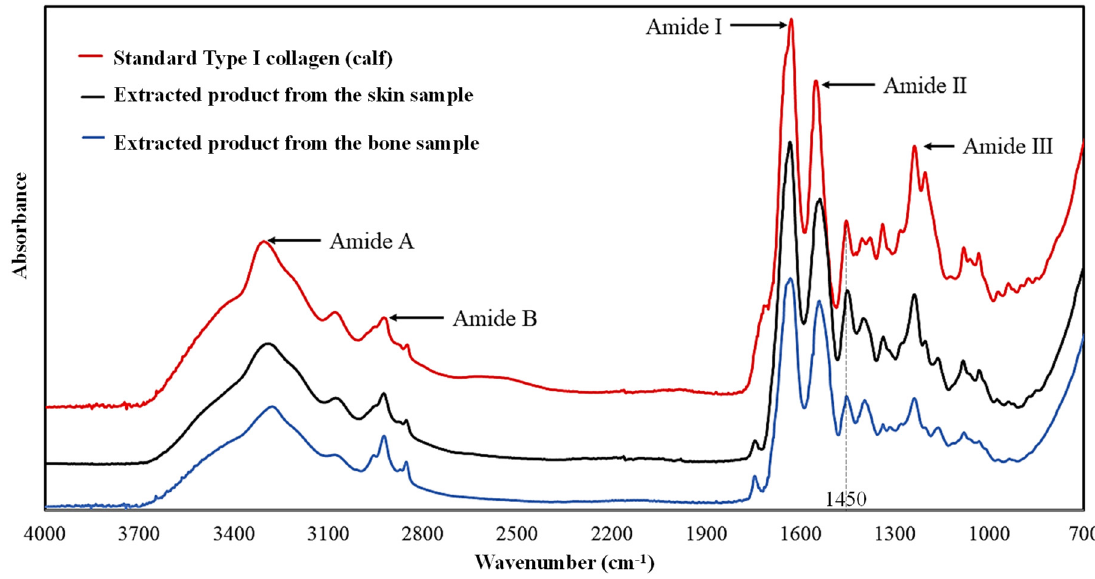
Figure 3. FTIR spectra of the extracted product obtained from the skin and bone of striped catfish.